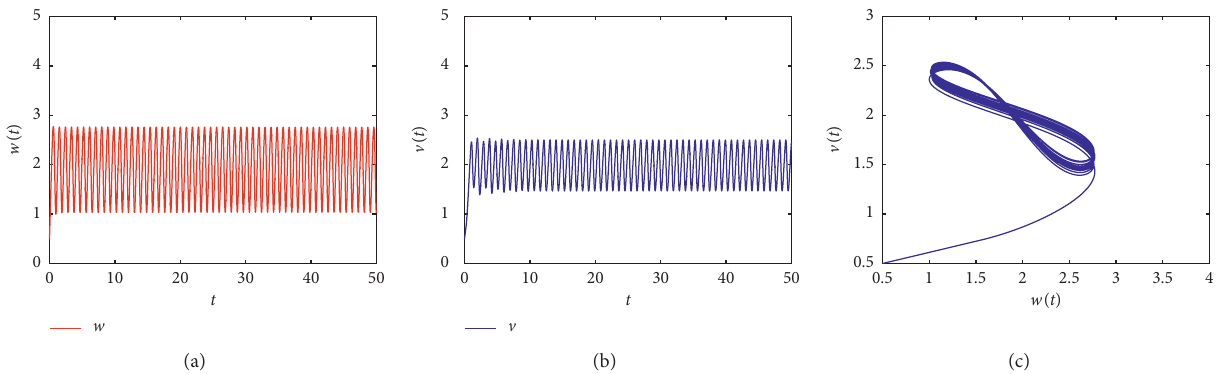
Figure 2: Computer simulation of the paths w ( t ) and v ( t ) for system (16) with the initial value ( w ( 0 ) , v ( 0 )) � ( 0 . 5 , 0 . 5 ) and ( t ) � τ ( t ) � 0 . 3 τ 1 2